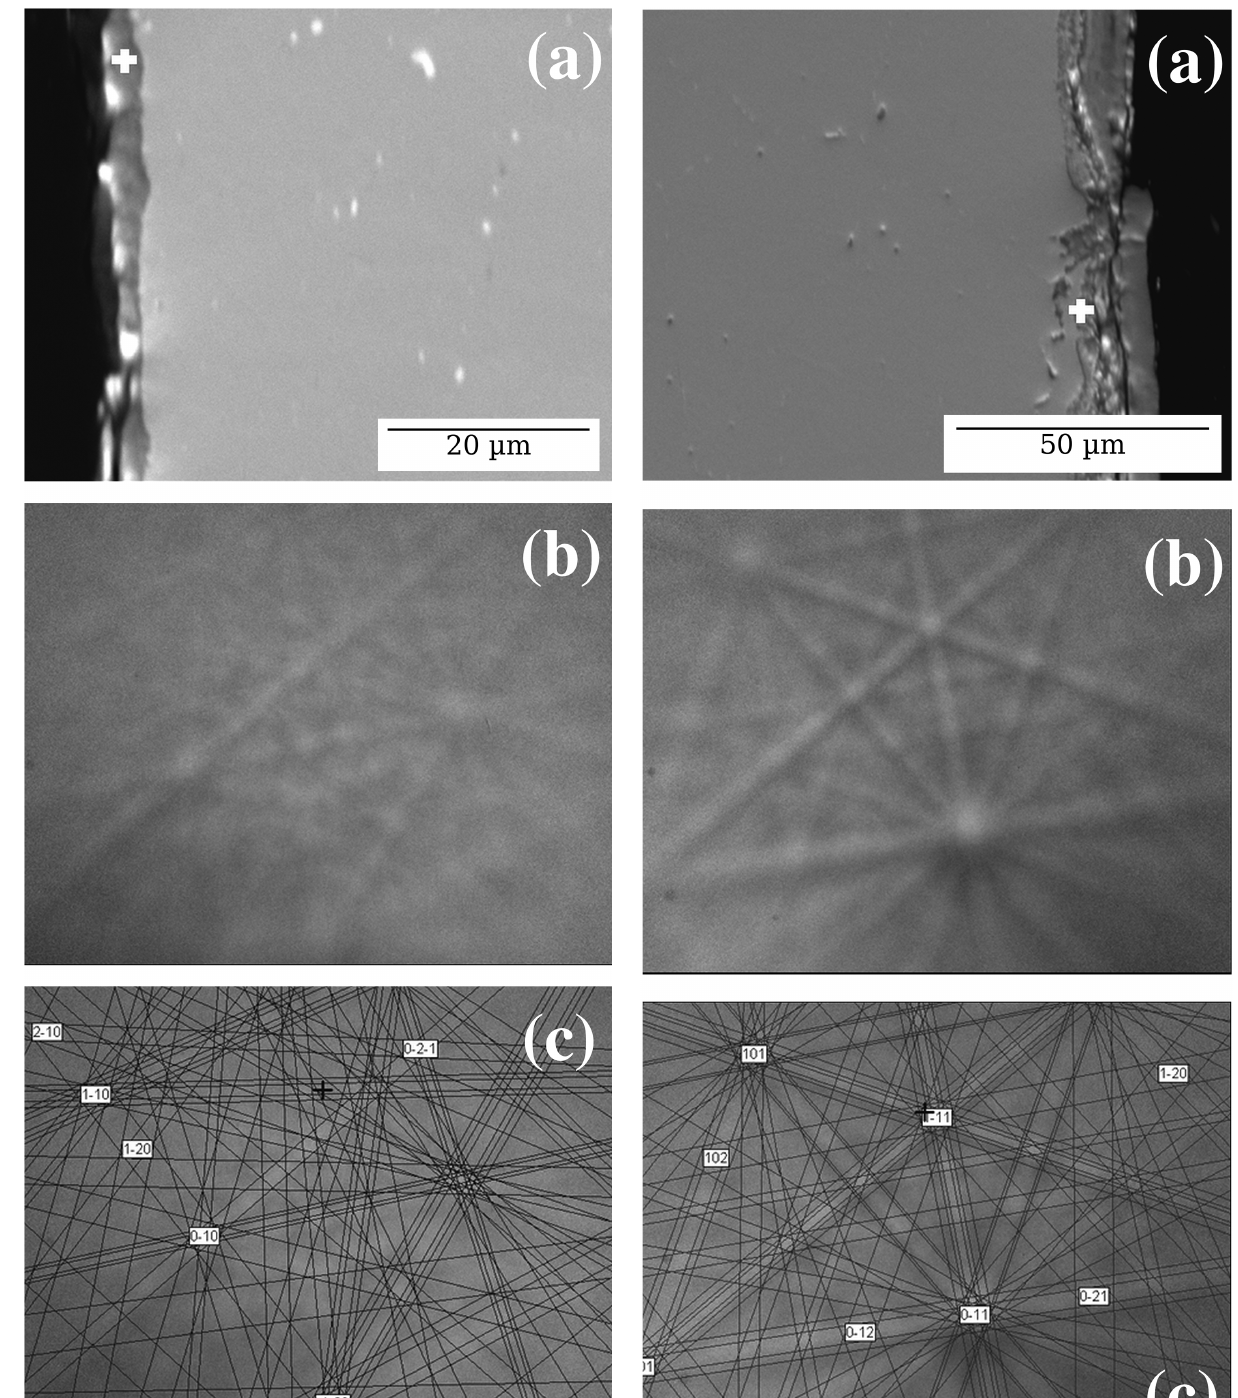
Figure 6: The results of EBSD analysis of the internal part of the oxide scale growing on the surface of the Super 304H steel sample: (a) cross-section of oxidized steel sample with marked micro-region, in which the EBSD analysis has been performed (b) an electron backscatter diffraction pattern (c) results of simulation of indexed planes for crystalline Cr 2 O 3 .